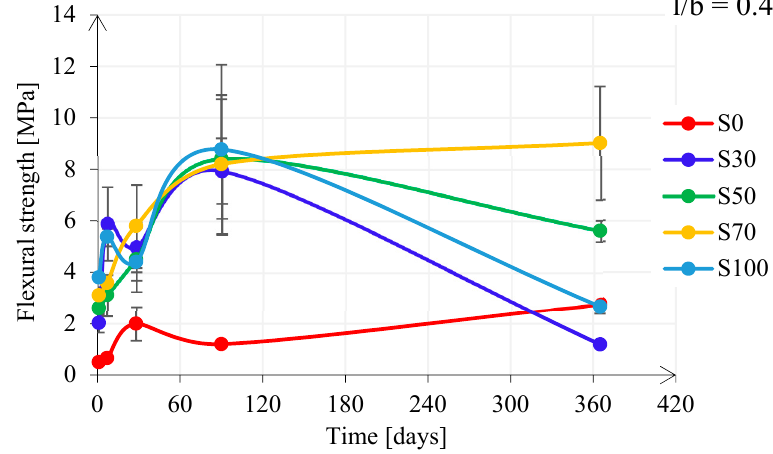
Figure 14. Flexural strength development for pastes with l/b = 0.4.